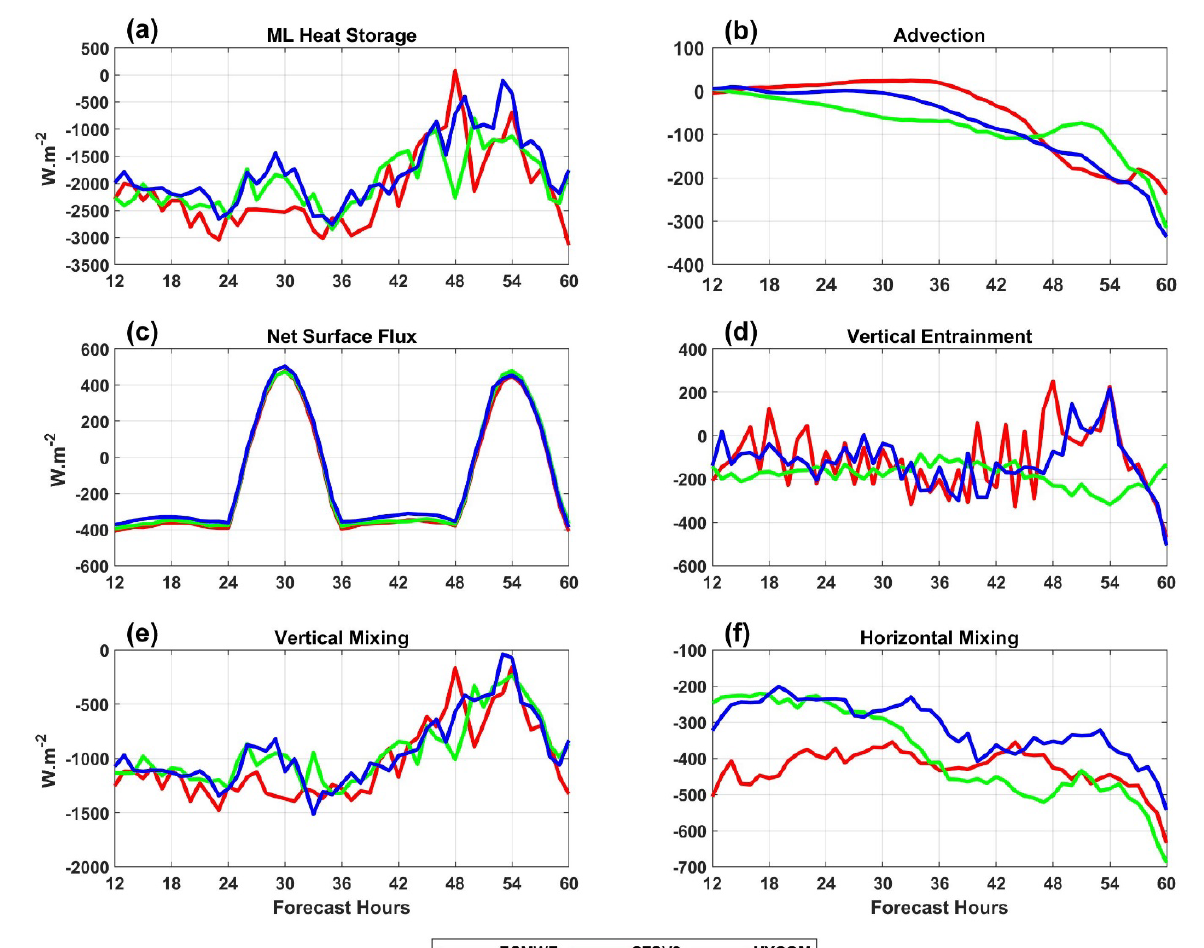
Figure 8. Time series for the different terms (W·m − 2 ) (i.e., ( a ) mixed layer (ML) heat storage rate, ( b ) advection due to currents, ( c ) net surface radiation, ( d ) vertical entrainment, ( e ) vertical mixing, and ( f ) horizontal mixing) of the ML heat budget (calculated over the VFB) obtained from all the experiments.